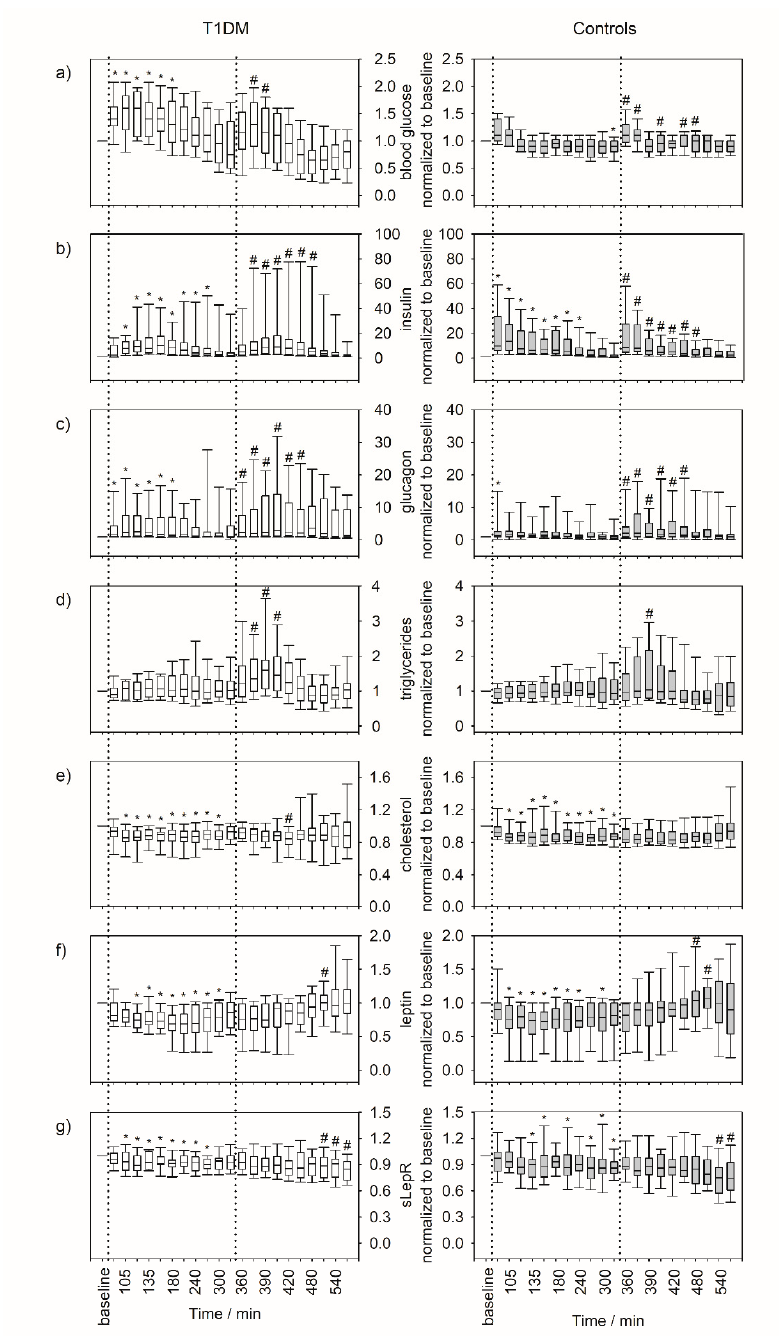
Figure 3. Box plots of serum parameters over the course of nine hours. ( a ) Blood glucose, ( b ) insulin, ( c ) glucagon, ( d ) triglycerides, ( e ) cholesterol, ( f ) leptin, and ( g ) sLepR. The graphs on the left show the course over of the nine hours of the experiment for T1DM patients ( n = 22), the graphs on the right show the corresponding data from healthy controls ( n = 22). Data were normalized to the baseline value (before breakfast) to emphasize relative changes and minimize inter-individual variation. Lunch was taken after the measurement at the 330th minute. Dotted lines indicate the intake of standardized meals. The asterisks (*) indicate statistically significant changes versus baseline (before breakfast) and hashes (#) indicate statistically significant changes versus the 330th minute (last measurement before